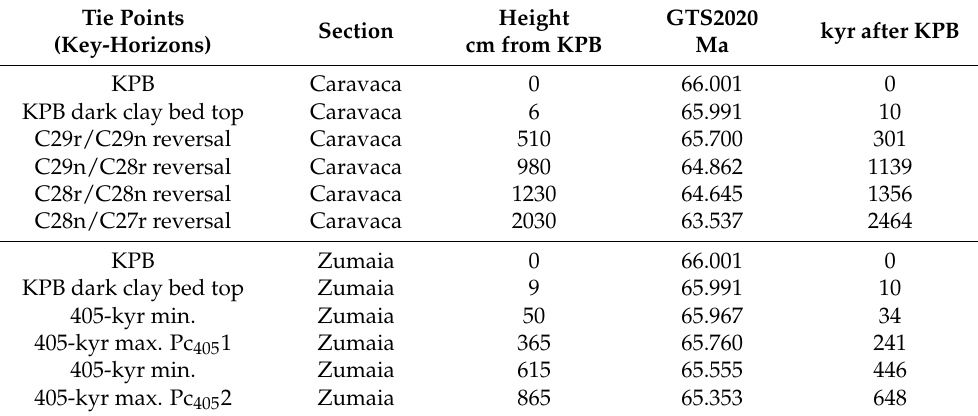
Table 1. Data for magnetochronological and astronomical calibrations in the Caravaca and Zumaia reference-sections. Stratigraphic position (cm from the KPB) of tie-points, and their calibrated ages (in Ma and kyr after the KPB) according to GTS 2020